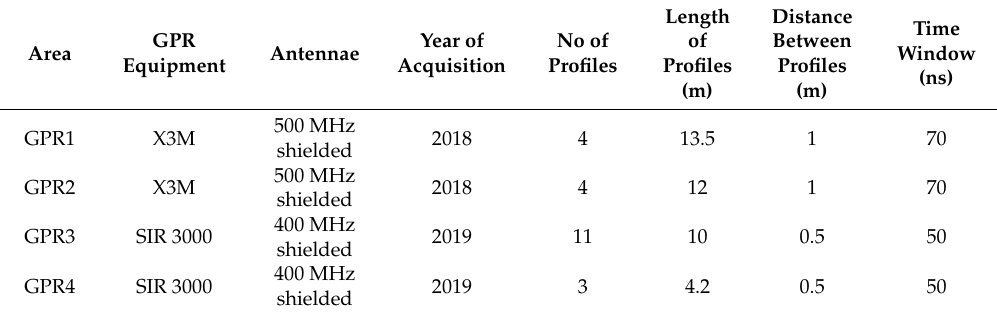
Table 1. Technical data of ground-penetrating radar (GPR)